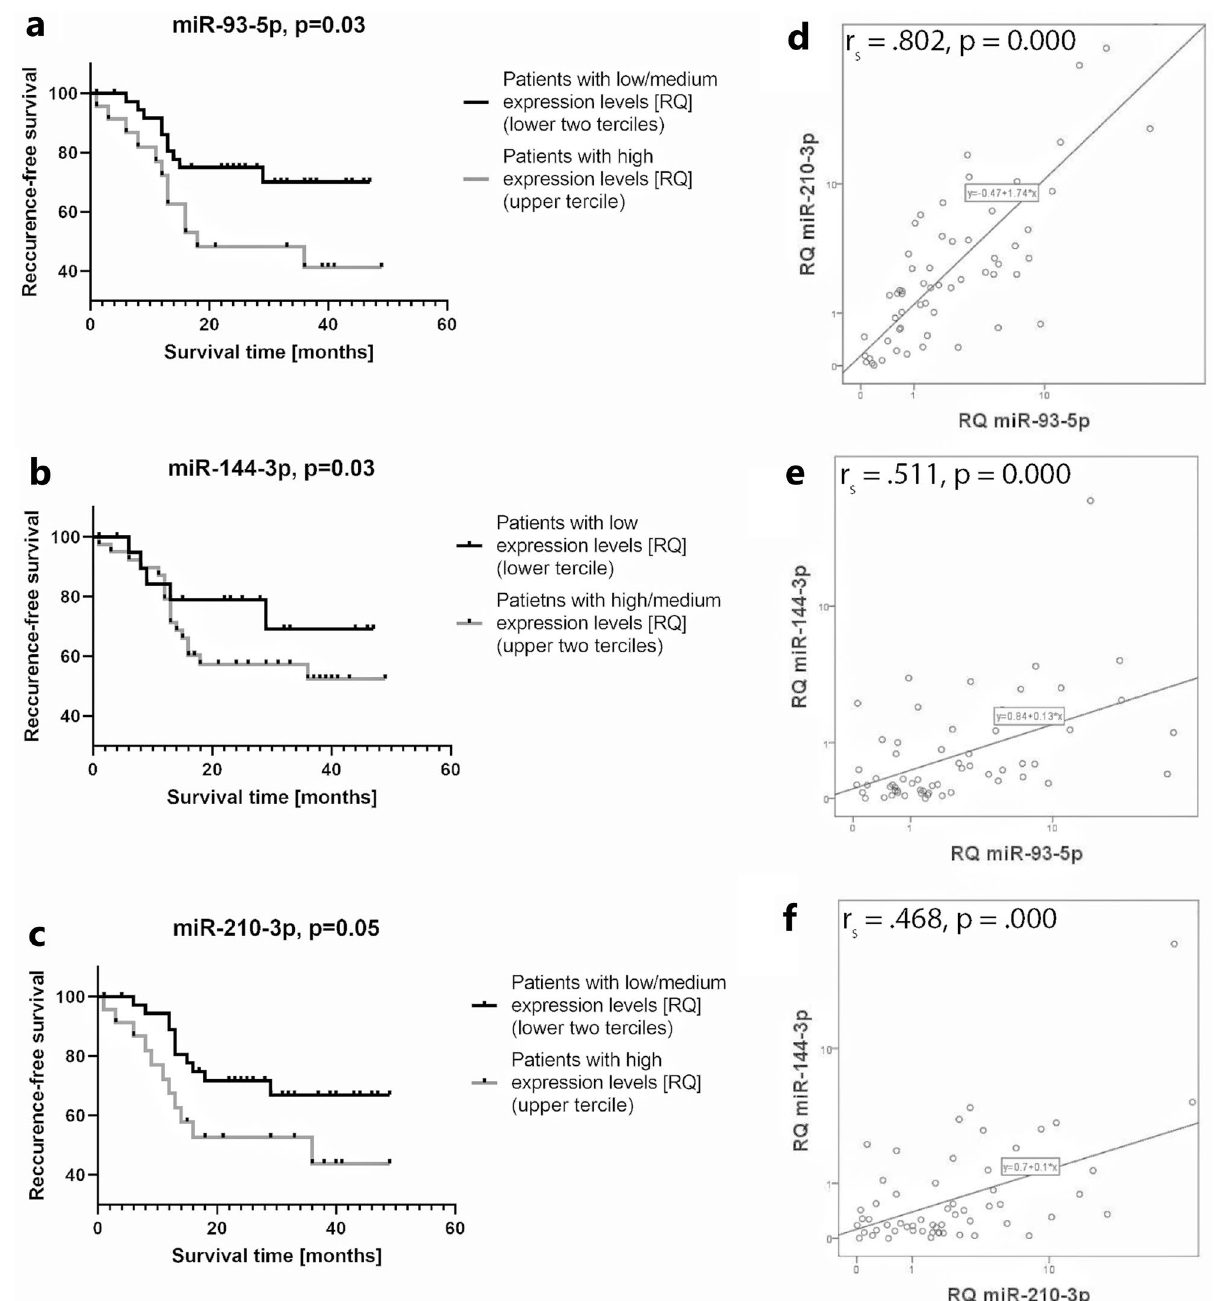
Figure 4. (a–c) : Kaplan–Meier curves illustrating that patients expressing higher levels of miR-93-5p, miR- 210-3p and miR-144-3p had significantly worse survival rates than patients with lower expression levels ( χ 2 (2) = 4.68, log-rank p = .03; χ 2 (2) = 4.53, log-rank p = .03, χ 2 (2) = 4.53, log-rank p = .03, respectively). (